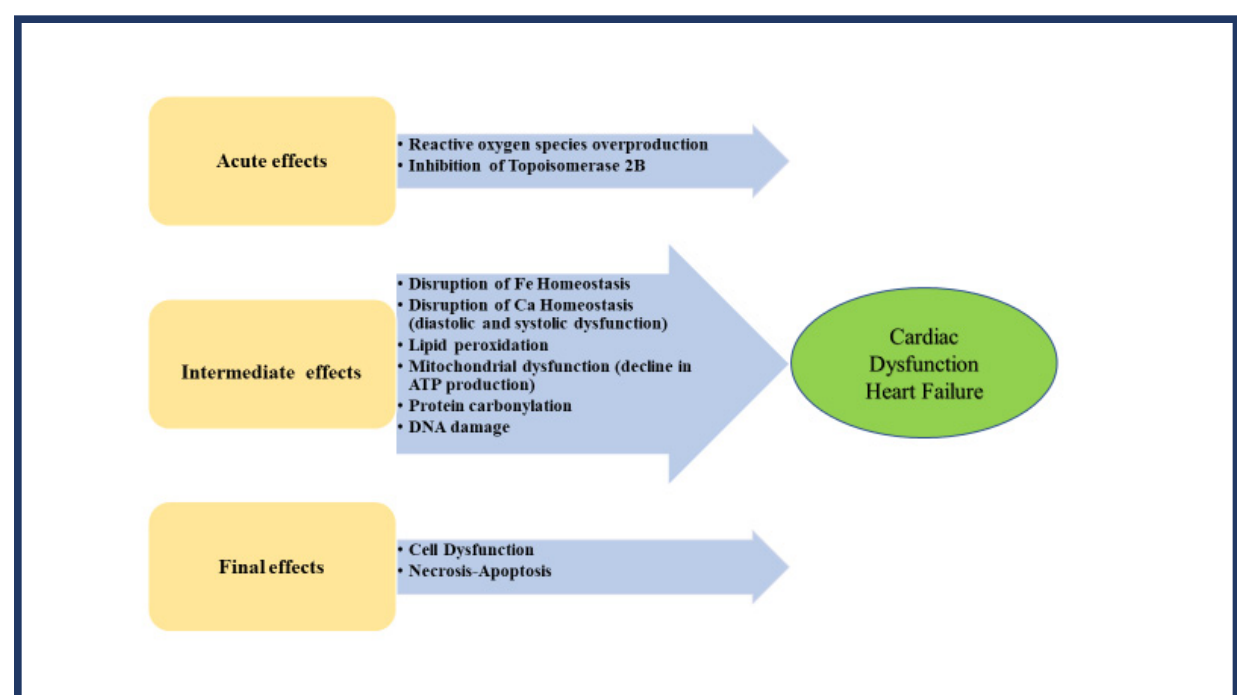
Figure 1. Mechanisms of Anthracycline-induced cardiotoxicity.